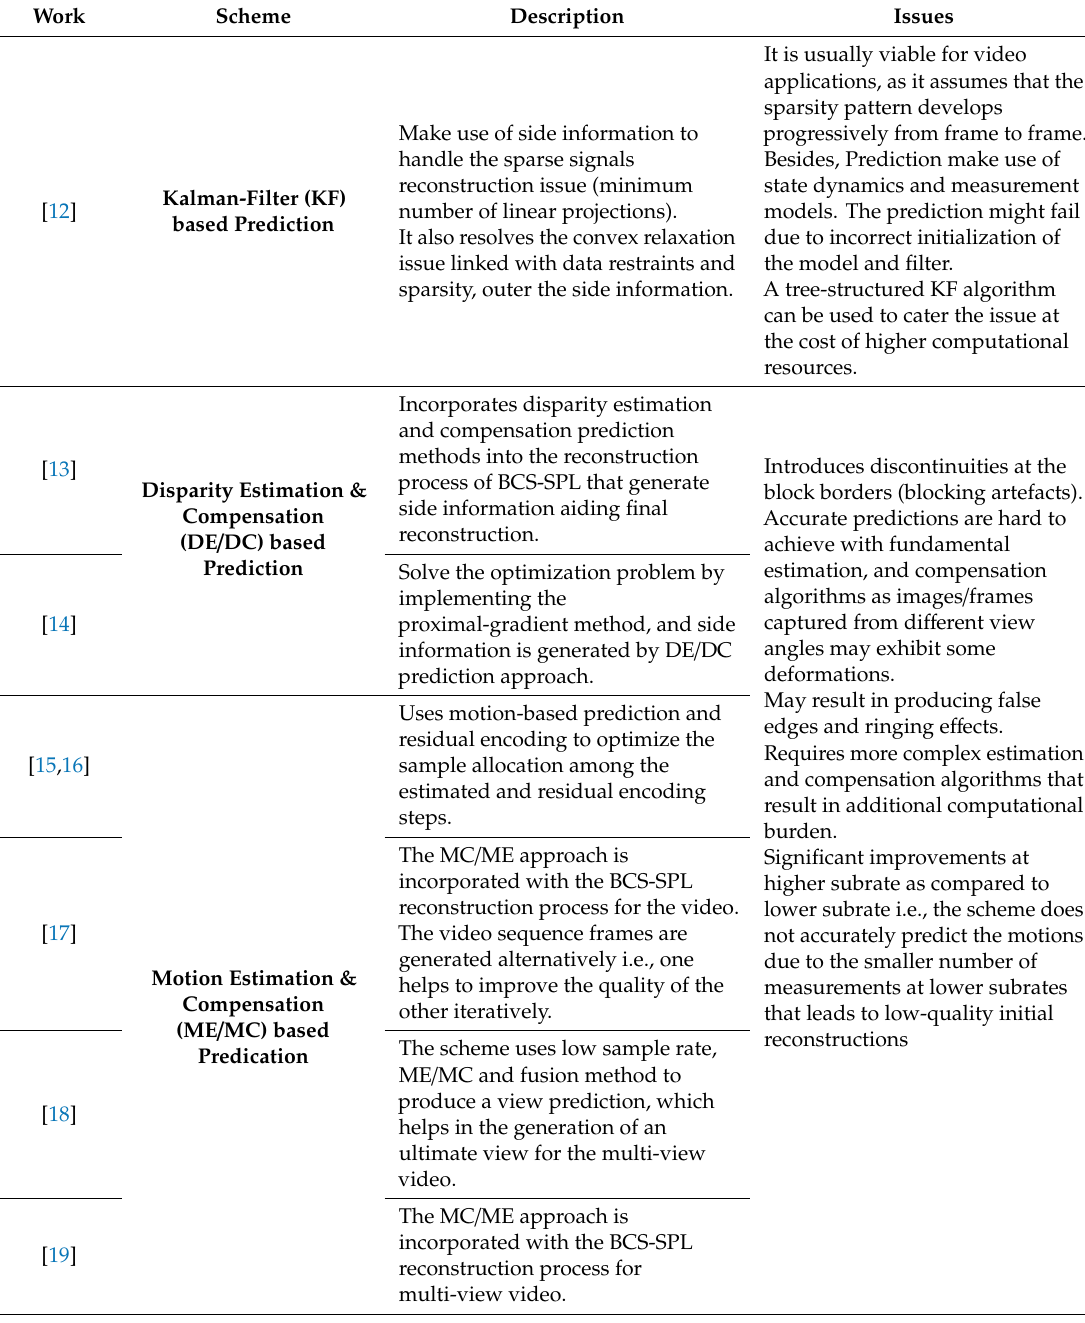
Table 1. Summary of various CS-based residual coding schemes for visual